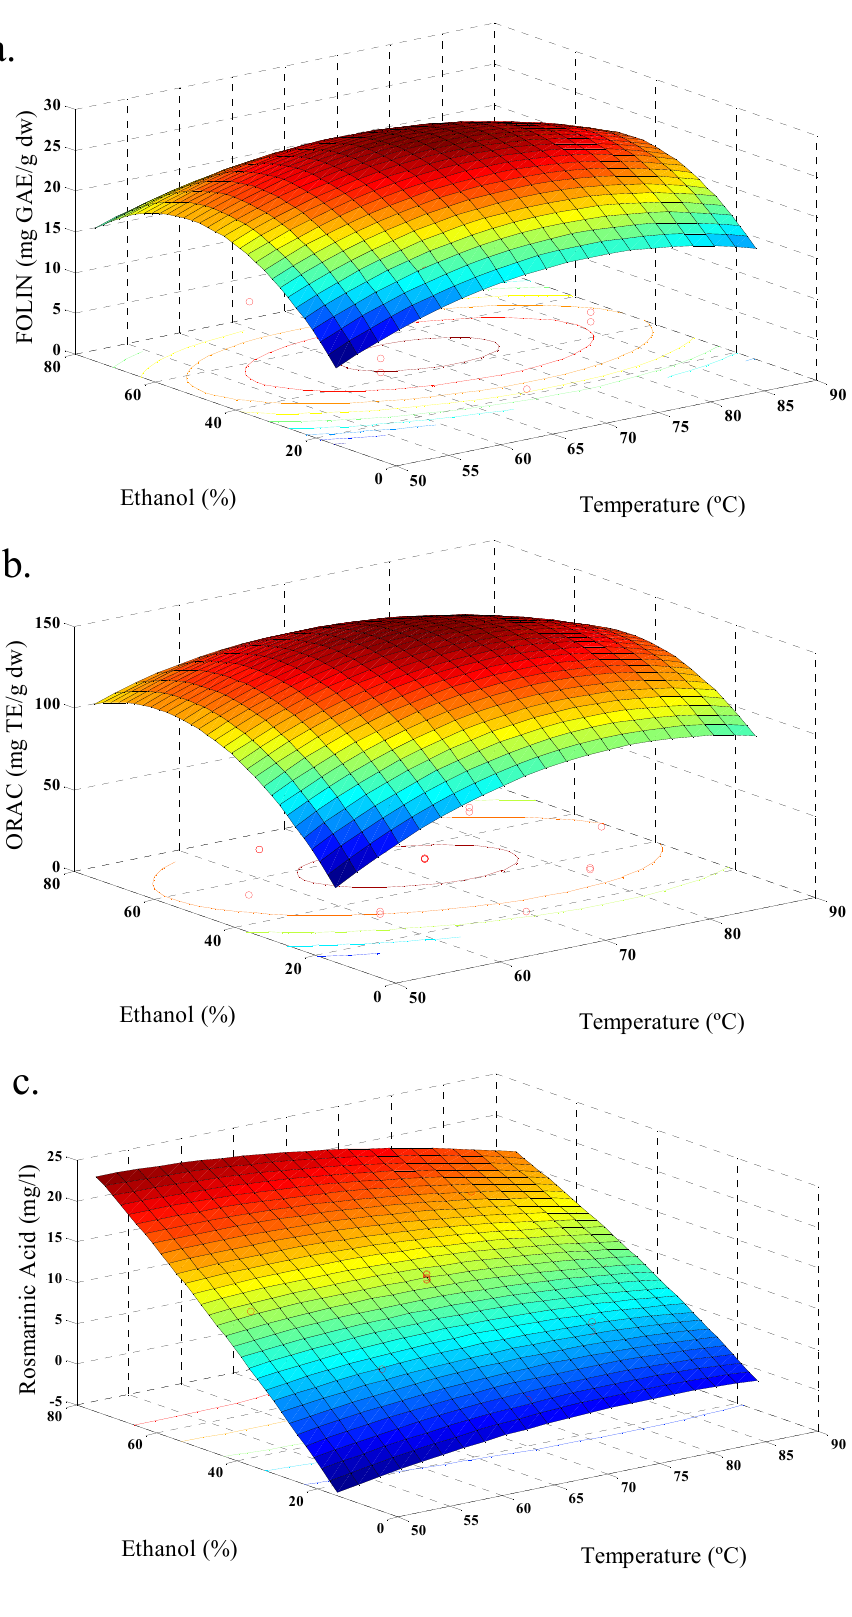
Figure 2. Response surface model plot, for ethanolic extraction, showing the effects of ethanol concentration and temperature on: ( a ) total polyphenols contents; ( b ) antioxidant activity (ORAC); and ( c ) rosmarinic acid